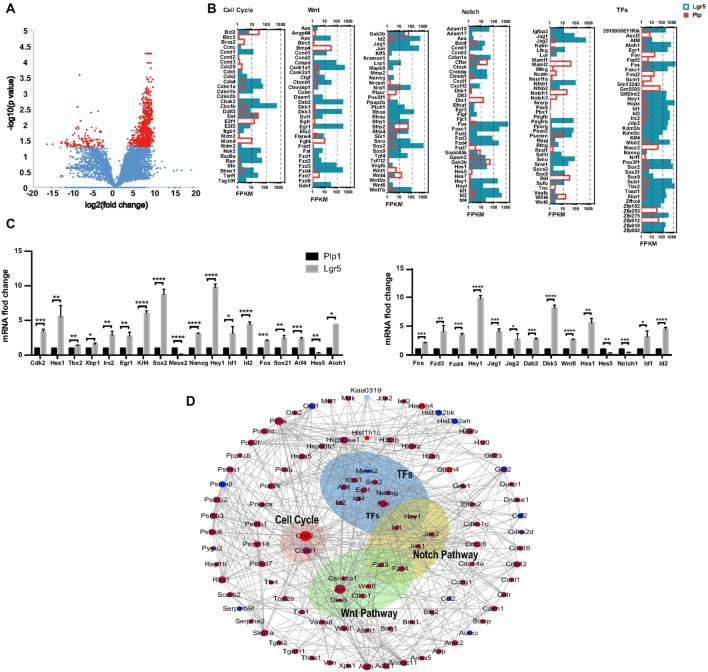
Wnt and Notch signaling pathway gene expression and cooperation between Lgr5+ SCs and Plp1+ SCs. (A) The volcano plot reflects the overall gene expression. The orange dots represent the differentially expressed genes, and the blue dots represent the non-differentially expressed genes. (B) The expression levels of genes involved in cell cycle regulation, the Wnt signaling pathway, the Notch signaling pathway, and transcription factors (TFs). The length of the bar after each gene represents its FPKM value. (C) Real-time PCR-validated differentially expressed genes involved in the cell cycle, TFs, and the Wnt and Notch signaling pathways. *p < 0.05, **p < 0.01, ***p < 0.001, ****p < 0.0001. (D) Gene interaction analysis of differentially expressed genes in Lgr5+ SCs (red) and Plp+ SCs (blue).